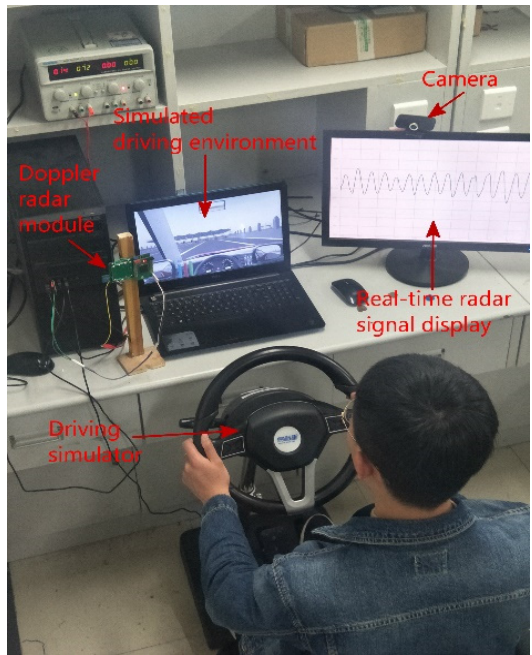
Figure 1. Physiological signal acquisition experimental platform.